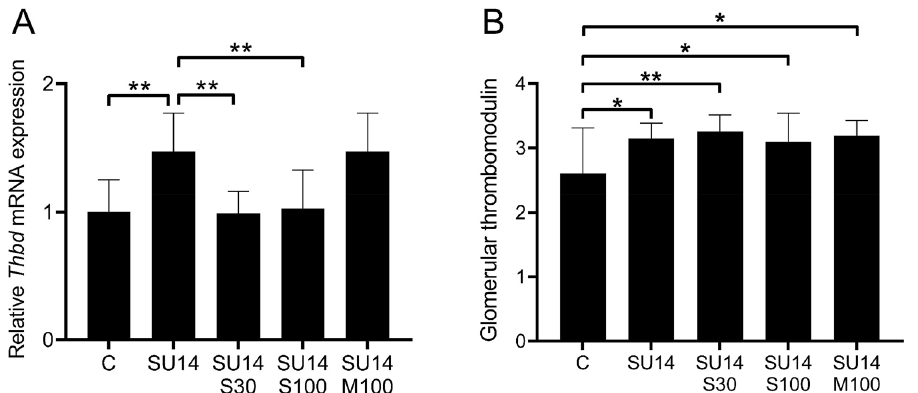
Figure 3. Renal thrombomodulin expression in rats exposed to sunitinib with sitaxentan or macitentan treatment. ( a ) Exposure to sunitinib results in a higher renal thrombomodulin mRNA expression, and sitaxentan (ET A R antagonist) at both dosages normalised this increase. ( b ) Sunitinib exposure resulted in a higher glomerular thrombomodulin protein expression compared to controls. Administration of sitaxentan (ET A R antagonist) nor macitentan (dual ET A/B R antagonist) resulted in a normalisation of the increased glomerular thrombomodulin protein expression. * p < 0.05, ** p <